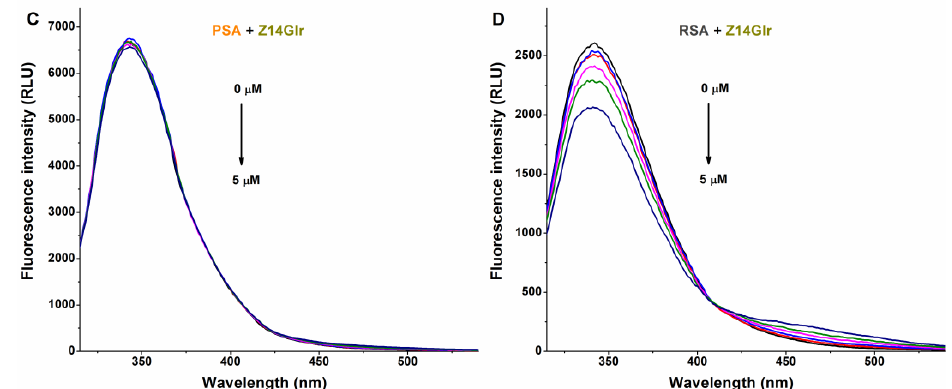
Figure 4. Representative fluorescence emission spectra of albumins, and the quenching effects of zearalenone - 14 - glucuronide (Z14Glr): Impacts of Z14Glr (0–5 μM) on the emission signals of human (HSA; ( A )), bovine (BSA; ( B )), porcine (PSA; ( C )), and rat (RSA; ( D )) serum albumins in PBS (pH 7.4; albumin concentration: 2 μM; λ ex = 295 nm).